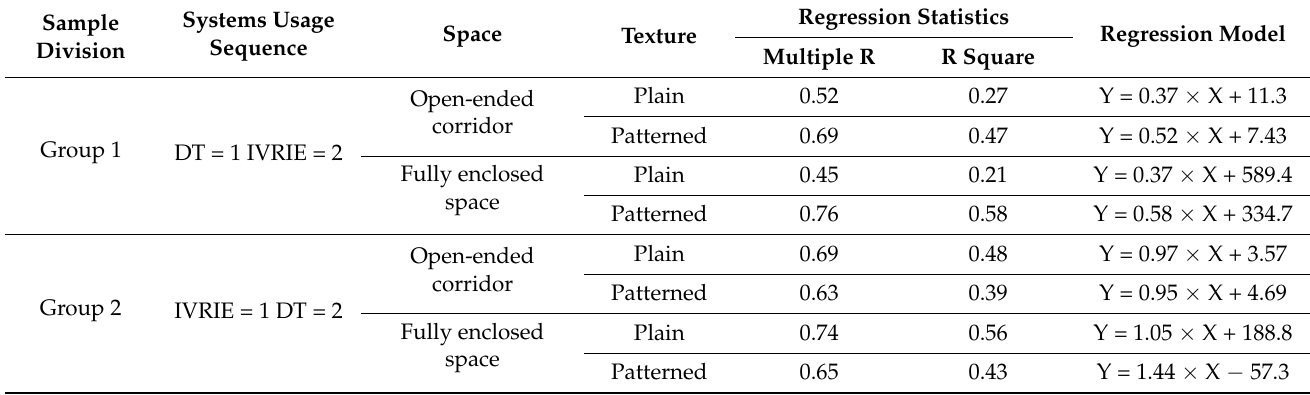
Table 3. Regression Statistics for the Open-Ended Corridors and Fully Enclosed Spaces Designed in Both Systems.